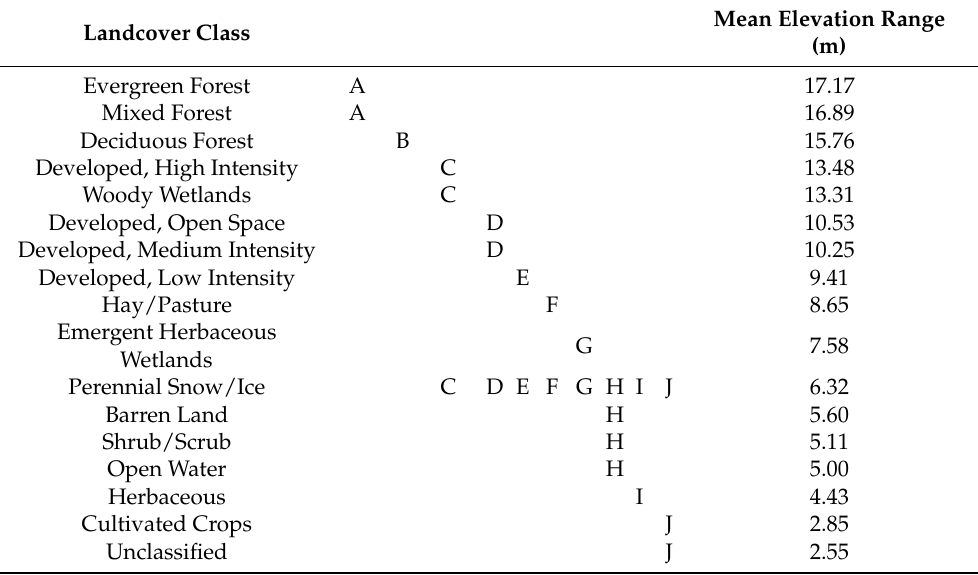
Table 8. Tukey’s honestly significant difference test comparing mean elevation range per 10-m pixel by landcover class. Land cover classes not connected by the same letter have means that are statistically significantly